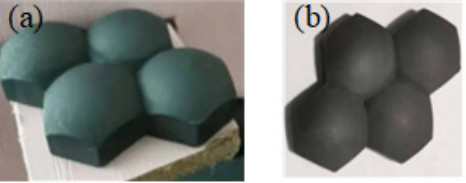
Figure 3. Photo of a 4-conjoined ceramic preform and sintered ceramic sheet at atmospheric pressure; ( a ) 4-conjoined ceramic billet; ( b ) sintered ceramic sheet at atmospheric pressure.